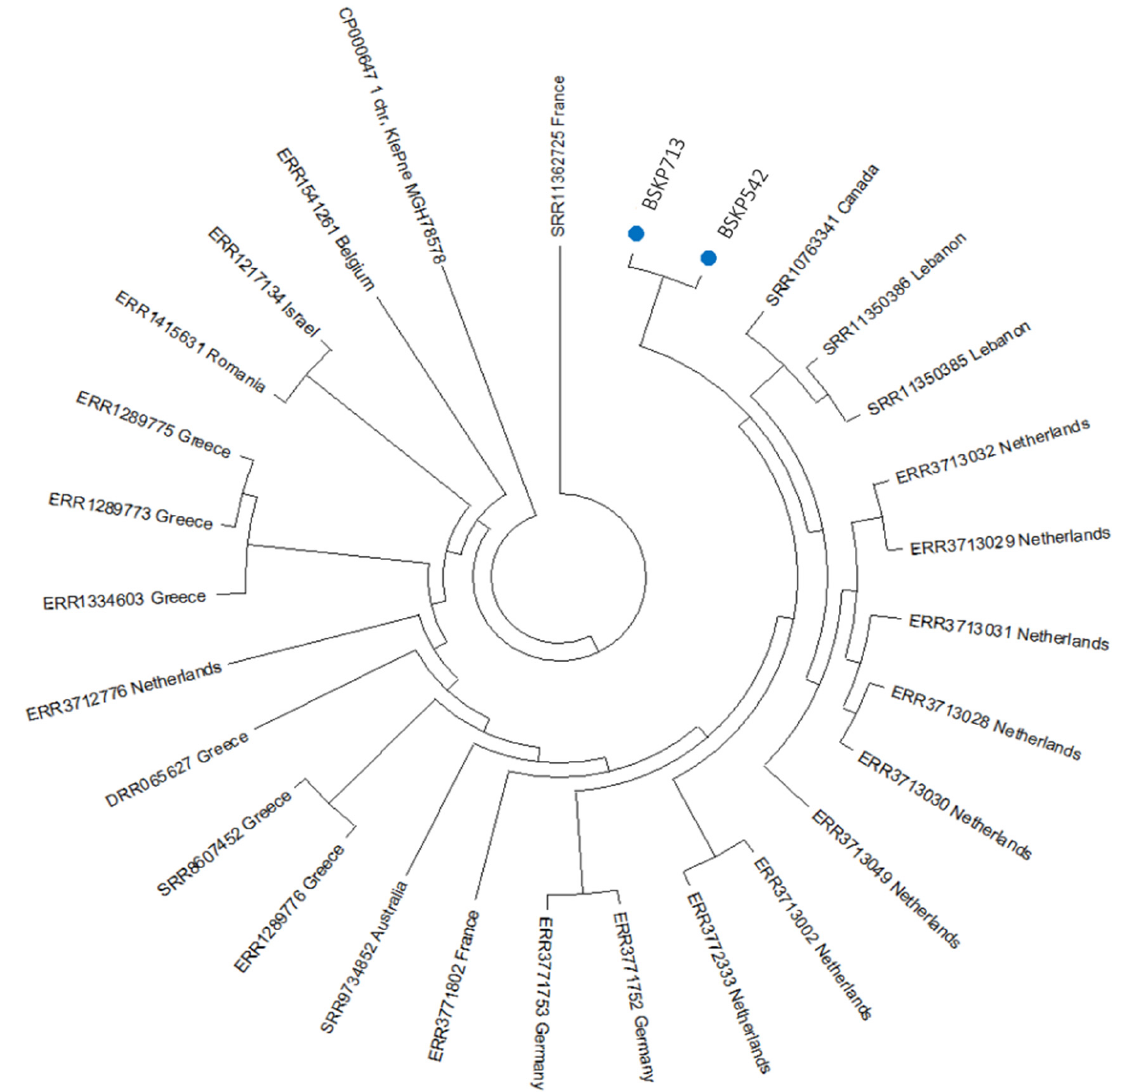
Figure 3. Phylogenetic tree showing evolutionary relationships among BSKP542 and BSKP713 isolated in this study and all the other isolates that also belonged to ST383. Our isolates are shown with blue circles. Klebsiella pneumoniae ATCC 700721 was employed as an outgroup.